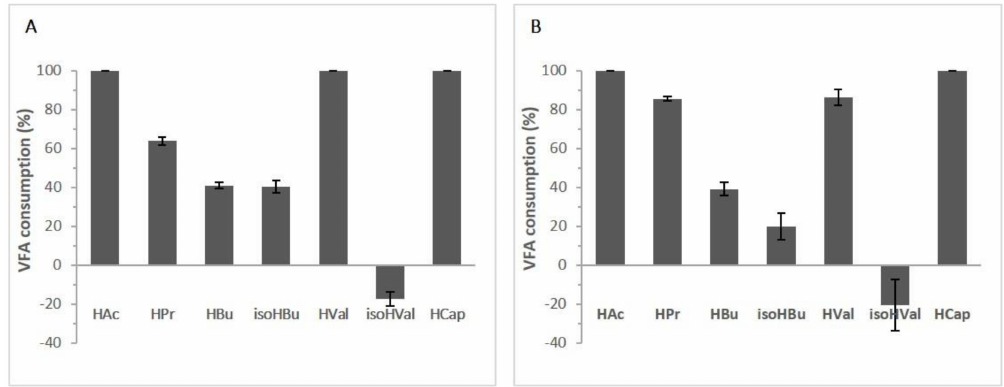
Figure 3. Volatile fatty acid (VFA) consumption (%) after 120 h of incubation in e ffl uent filtrate obtained from anaerobic digestion of organic wastes for: ( A ) Candida tropicalis V139 and ( B ) Metschnikowia pulcherrima V213. Values represent mean of triplicates ± standard